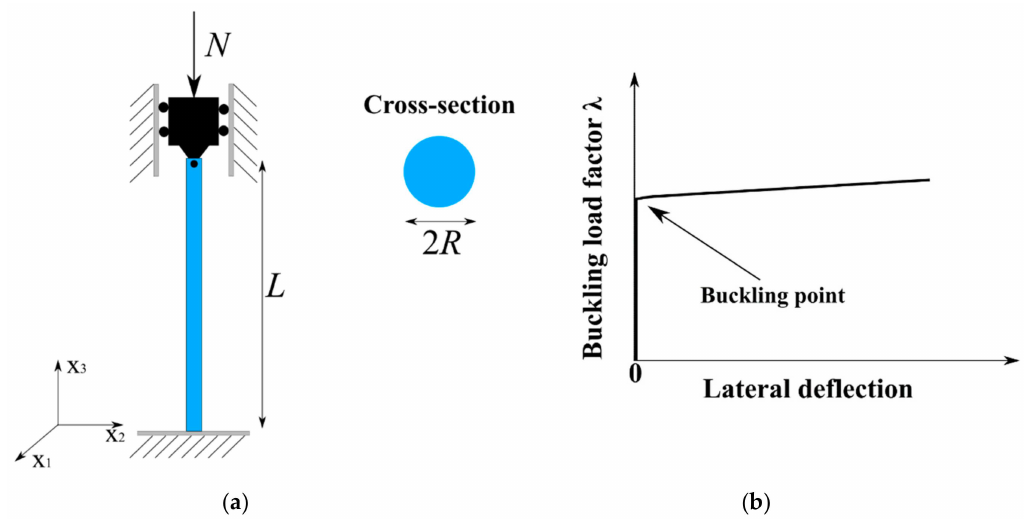
Figure 1. Description of column under axial loading: ( a ) schematization of the column considered in this study, including length, geometry of cross-section, fixed-pinned boundary conditions and axial loading at the top surface, and ( b ) typical mechanical response of columns under axial compression (buckling load factor versus lateral